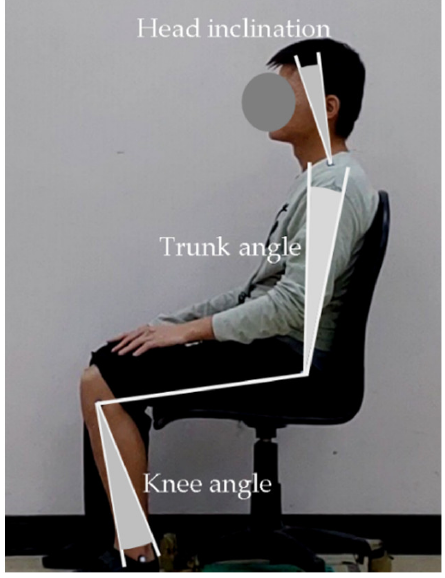
Figure 4. Ranges of the angle variations for each joint based on the five repeated trials.